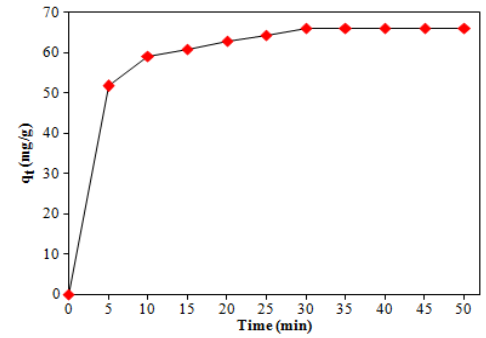
and contact t time ( t